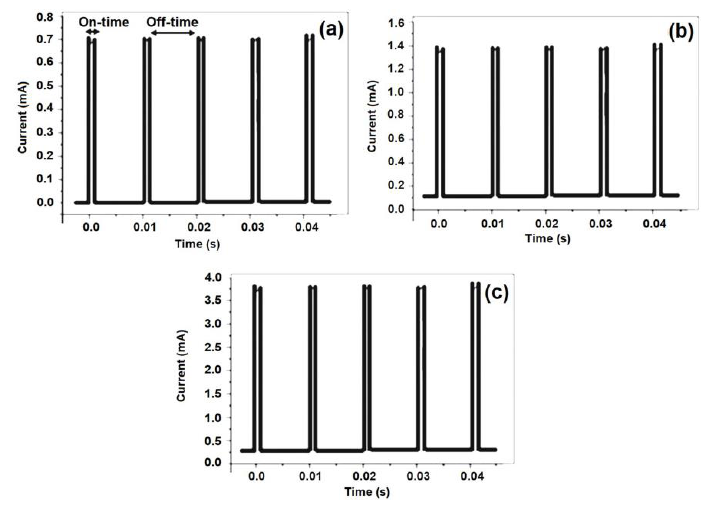
Figure 2. The current profile used for the various potentiostatic potential ( a ) − 0.5 V, ( b ) − 1.1 V, and ( c ) − 3.2 V. Table 1. Experimental conditions and pulse parameters.